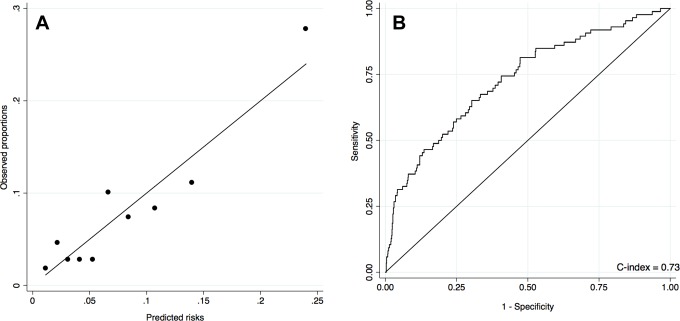
(A) Calibration curve of the prediction model of the risk of stress fracture during 32-week Marines training. The solid line indicates perfect calibration. (B) Receiver operating characteristic curve plot to assess discrimination of the predictive model.